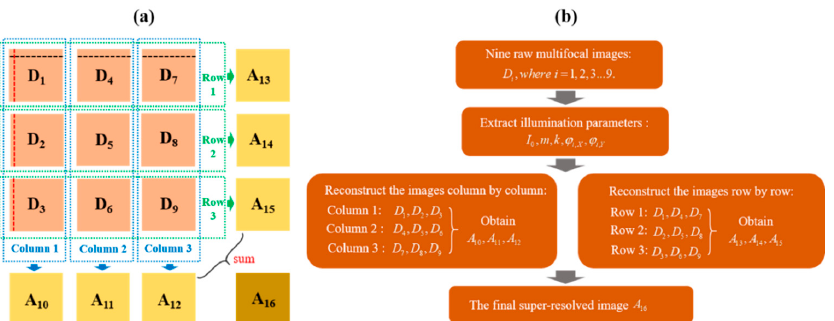
Figure 3. Framework of the reconstruction procedure for the multifocal structured illumination microscopy (MSIM) data. ( a ) The procedure of the reconstruction for the MSIM data, where D 1 –D 9 are nine raw multifocal images arranged in three rows and three columns. A 10 –A 12 are obtained images reconstructed with Column 1–Column 3, while A 13 –A 15 are obtained images reconstructed with Row 1–Row 3, respectively. A 16 is the final super-resolved image obtain by the sum of A 10 –A 16 . ( b ) Schematic of the reconstruction procedure for the MSIM data.